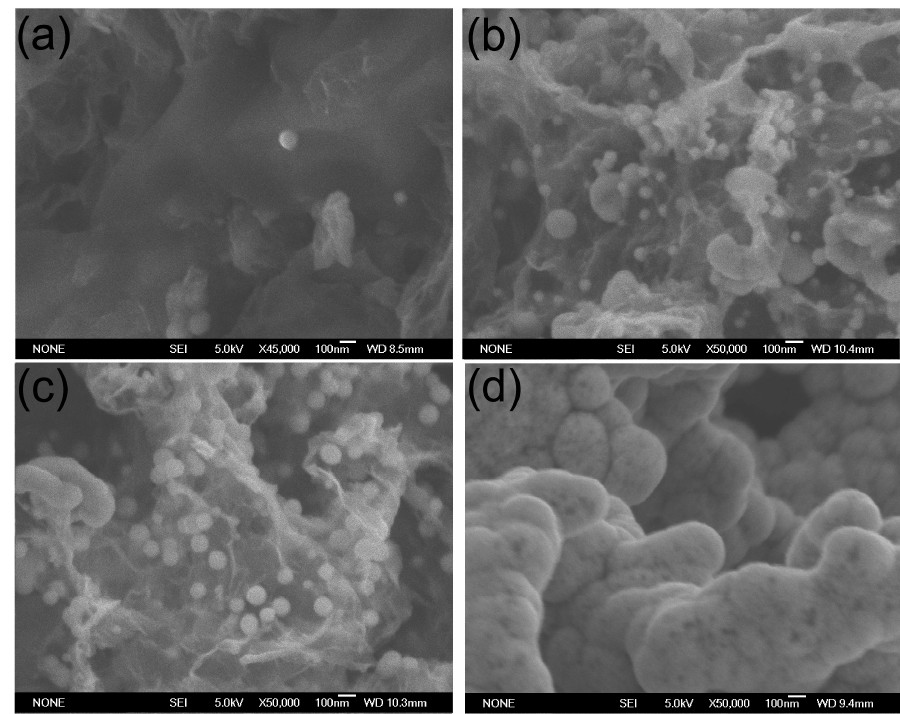
Figure 2. SEM images of GA/Co-Fe-P samples: ( a ) Sample-h2; ( b ) Sample-h4; ( c ) Sample-h8; ( d ) Sample-h14.